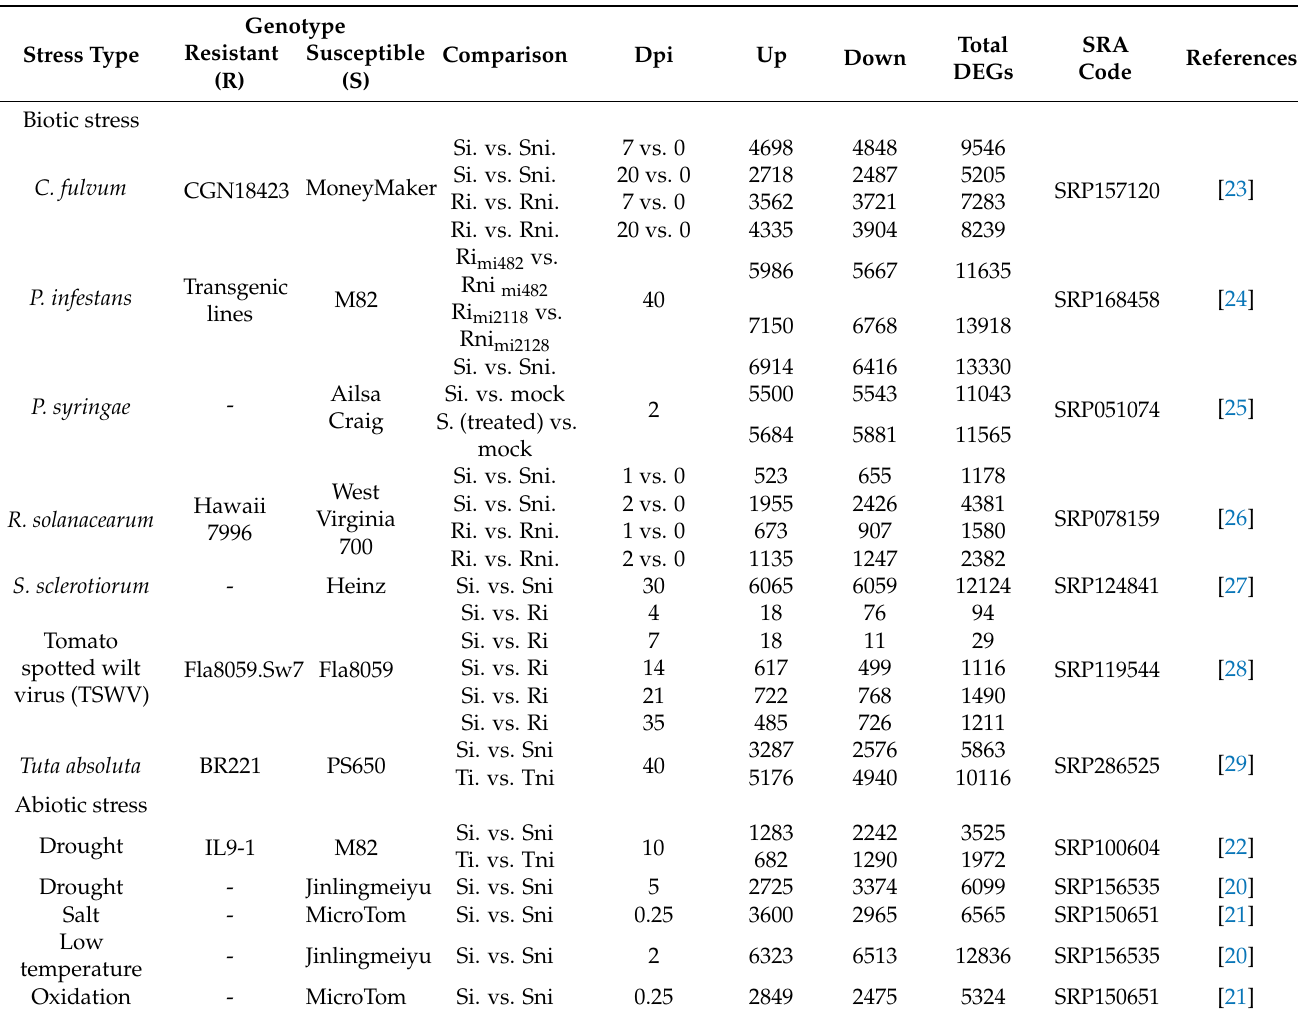
Table 1. Transcriptomic responses to biotic and abiotic stress analyzed in this study. The number of up and downregulated genes and total differentially expressed genes (DEGs) has been reported for each experiment. Si = susceptible stressed; Ri = resistant stressed; Sni = susceptible not stressed; Rni = resistant not stressed; Ti = tolerant stressed; Tni = tolerant not stressed; Dpi = days post- induced